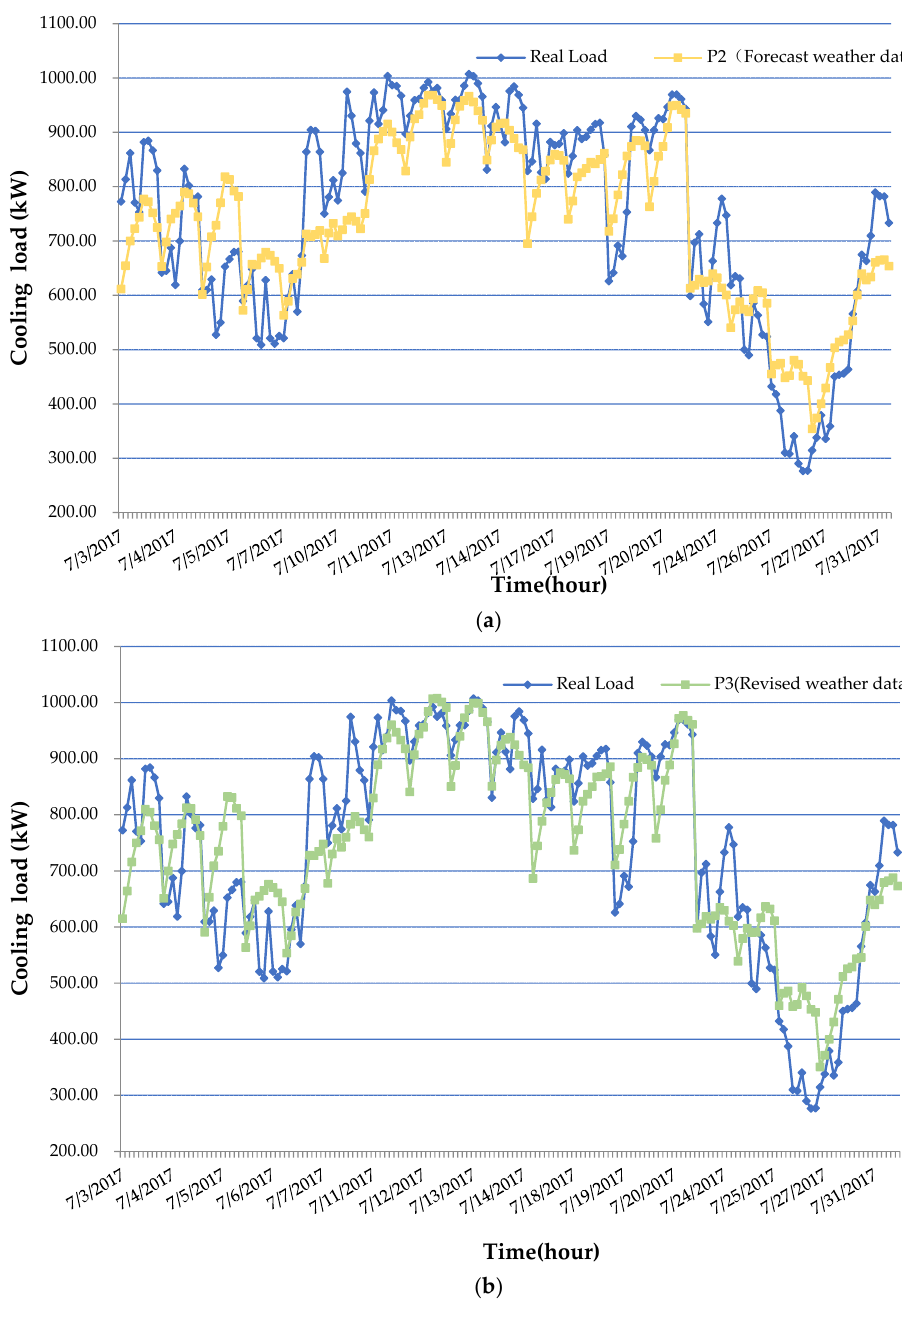
Figure 10. In ( a ), P2 is the forecasting load adopting weather forecast data, and in ( b ), P3 is the forecasting load adopting the weather forecast data dealt with MCM.